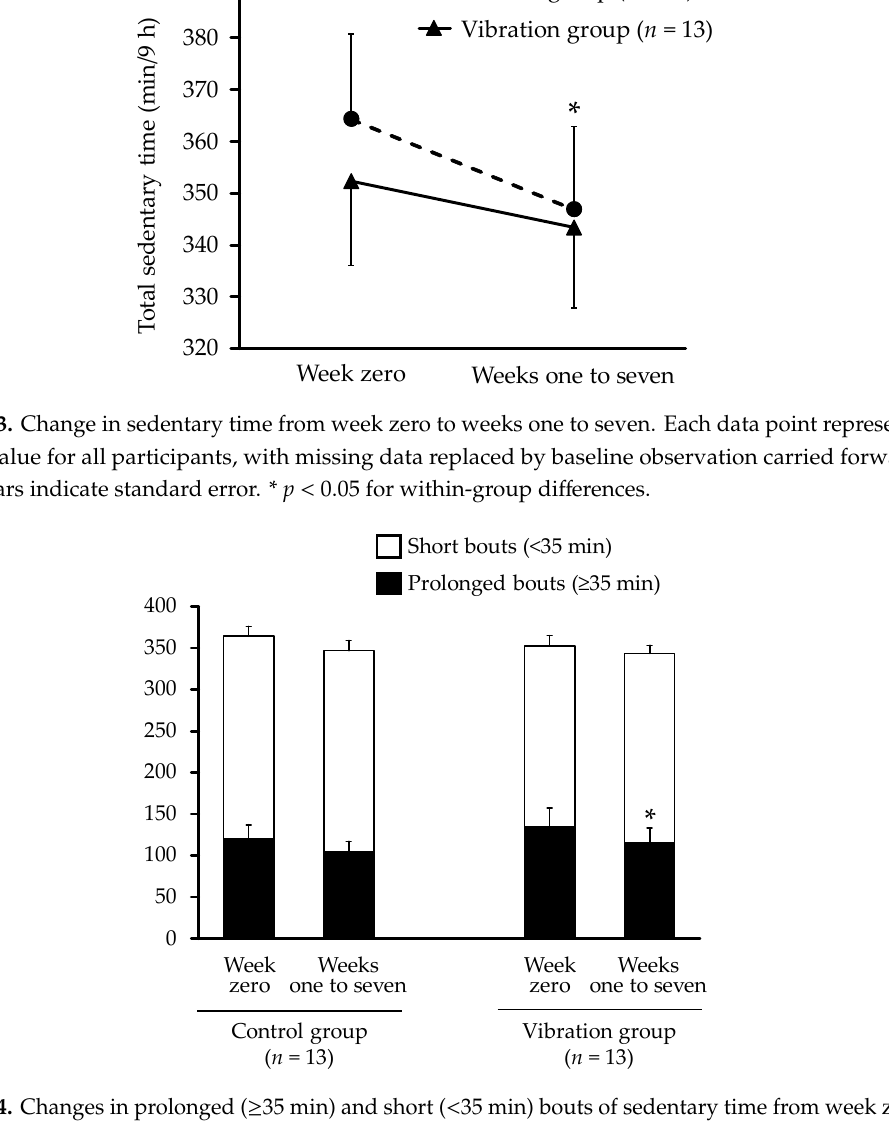
Figure 4. Changes in prolonged ( ≥ 35 min) and short (<35 min) bouts of sedentary time from week zero to weeks one to seven. Each data point represents mean value for all participants, with missing data replaced by baseline observation carried forward. Error bars indicate standard error. * p < 0.05 for within-group differences. Table 2. shows the changes in posture measurements. There were no significant between-group differences for any measurements. The change from week zero to weeks one to seven in standing time increased significantly within the control group.